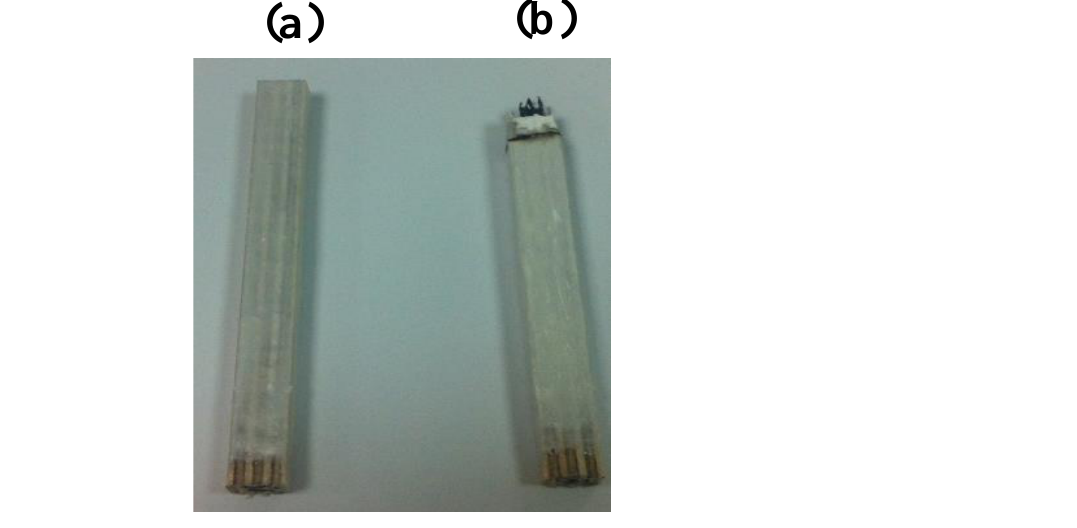
Figure 3. Plywood specimens prepared for LOI measurements. Unburned specimen coated with ( a ) polymer matrix/H5/additive and ( b ) burned specimen.